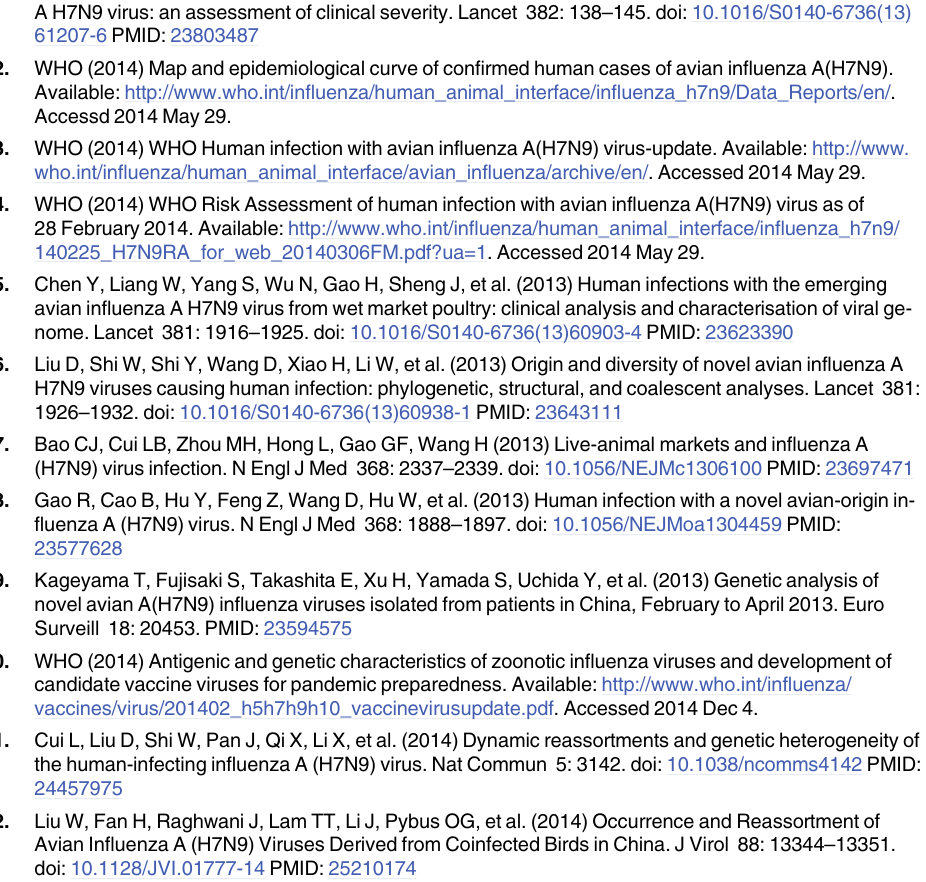
S1 Table. The nucleotide identity of the four imported influenza A(H7N9) and selected representative isolates, compared to the full-length sequences of A/Anhui/1/2013 virus.